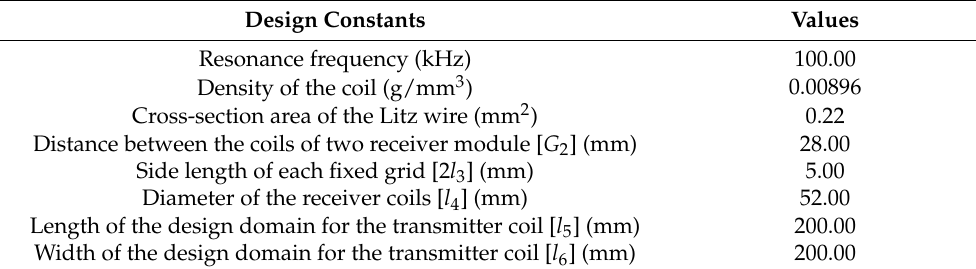
Figure 2. Description of the application model for S-M WPT systems with two receiver modules. Table 1. Detailed information on the application model